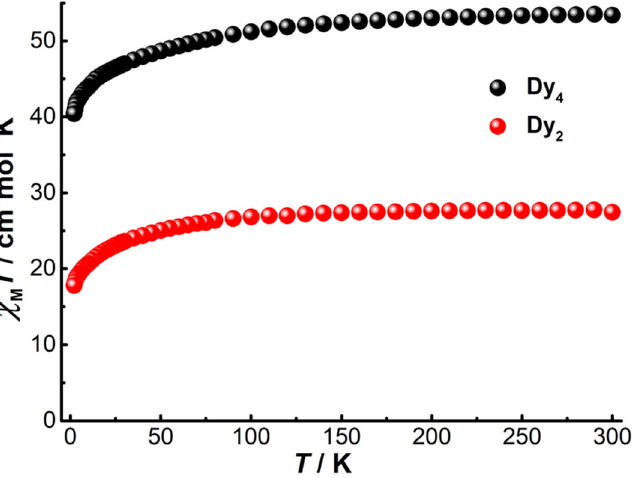
Figure 2. Temperature-dependent χ M T products at 1 kOe between 2 and 300 K for Dy 2 and Dy 4